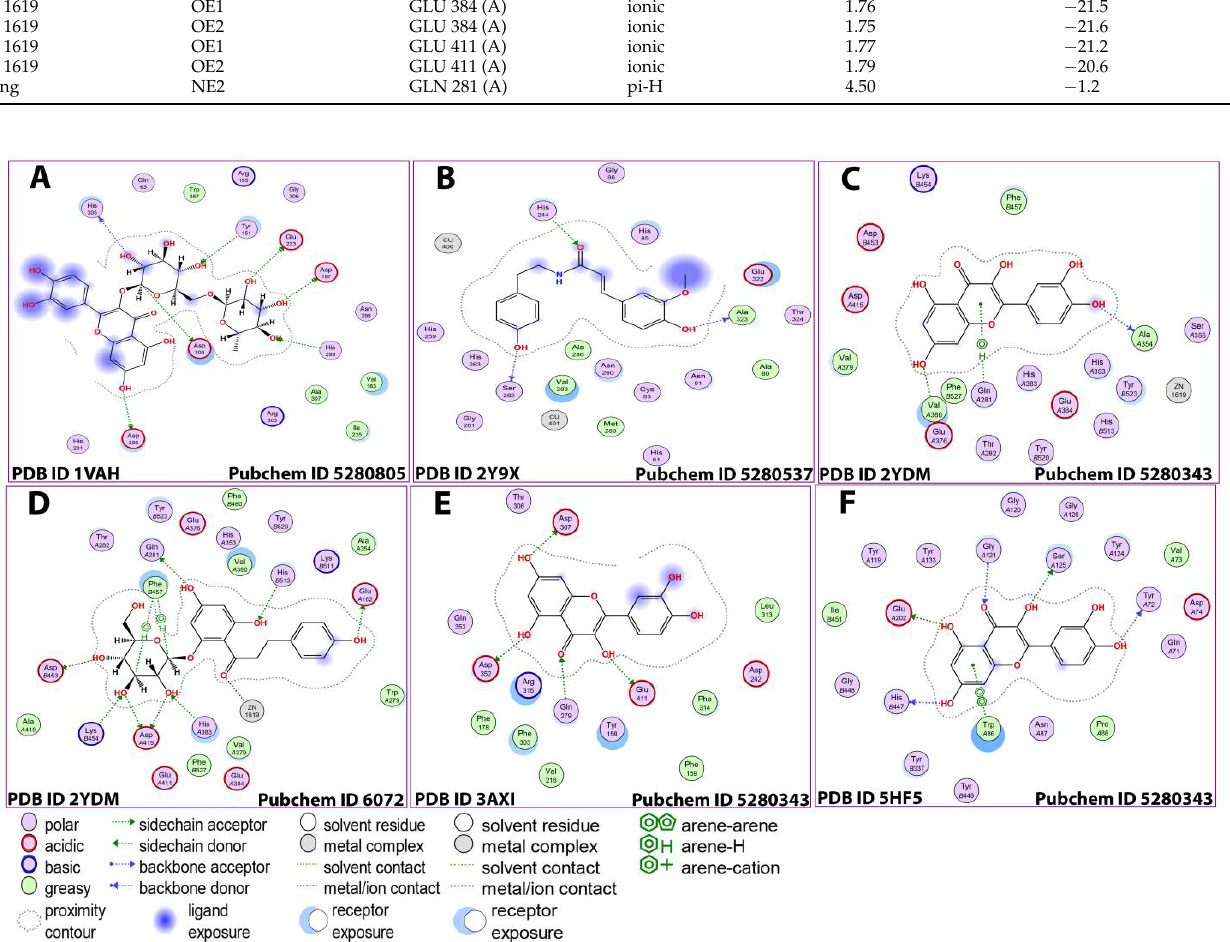
Figure 5. Results of detailed docking ( A – F ).